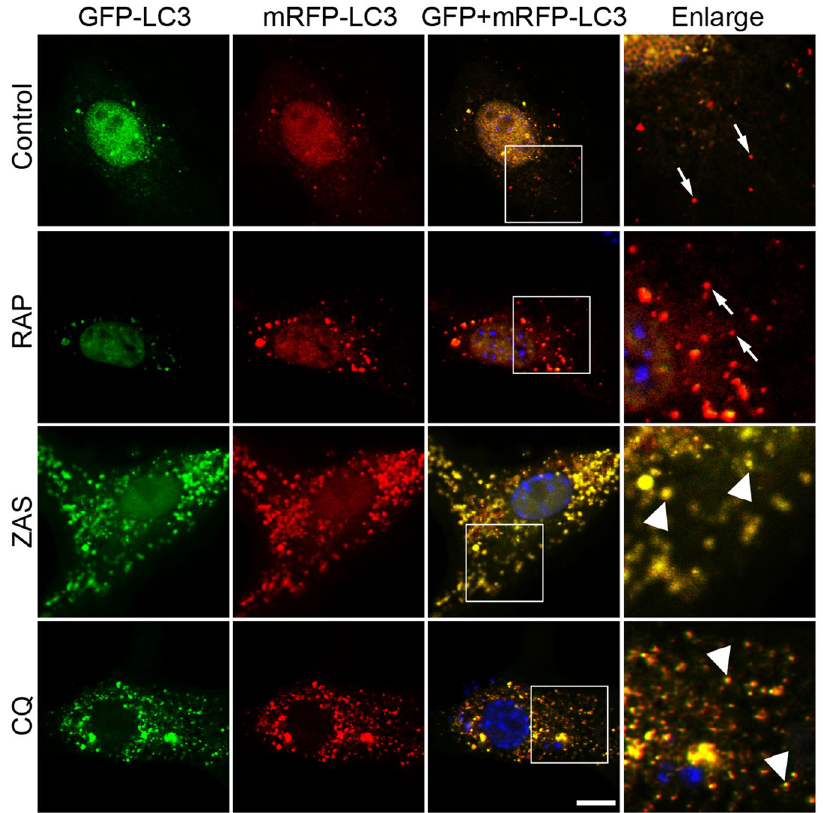
Figure 5. Zymosan activation serum (ZAS) blocks autophagic pathway by inhibiting autolysosome formation. Autophagic flux analysis with tandem mRFP-GFP fluorescent-tagged LC3 (tfLC3) plasmid, which showed GFP and mRFP fluorescence signals (yellow) before the autophagosomes fusion with lysosomes, whereas exhibited only the mRFP fluorescence signal (red) after autophagosome and lysosome fusion to become autolysosome due to GFP fluorescence signal (green) quenched in acid environment. After transfection, the cultured podocytes were subjected to heat-inactivated human serum (HIS), rapamycin (RAP, 10 μ M), ZAS, or chloroquine (CQ, 10 μ M) treatment for different times, fixed, and analyzed by confocal microscopy. The positive control podocytes treated with RAP displayed much more autolysosomes (free red dots) in the cytoplasm compared with the HIS treated control podocytes. However, ZAS induced accumulation of autophagosomes exhibiting increased yellow puncta but almost no free red dots in the cytoplasm from 4 to 36 h. The number of yellow puncta (autophagosomes) was also significantly increased in the presence of CQ. The representative images at 36 h were shown in this study. Arrowheads indicate autophagosomes. Arrows indicate autolysosomes. Scale bar, 10 μ